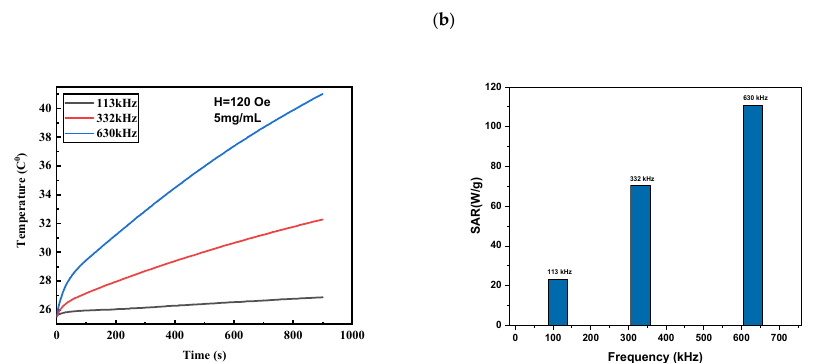
Figure 7. ( a ) Temperature rise at different frequency and field amplitude of 120 Oe for concentration of 5 mg/mL and ( b ) SAR values.